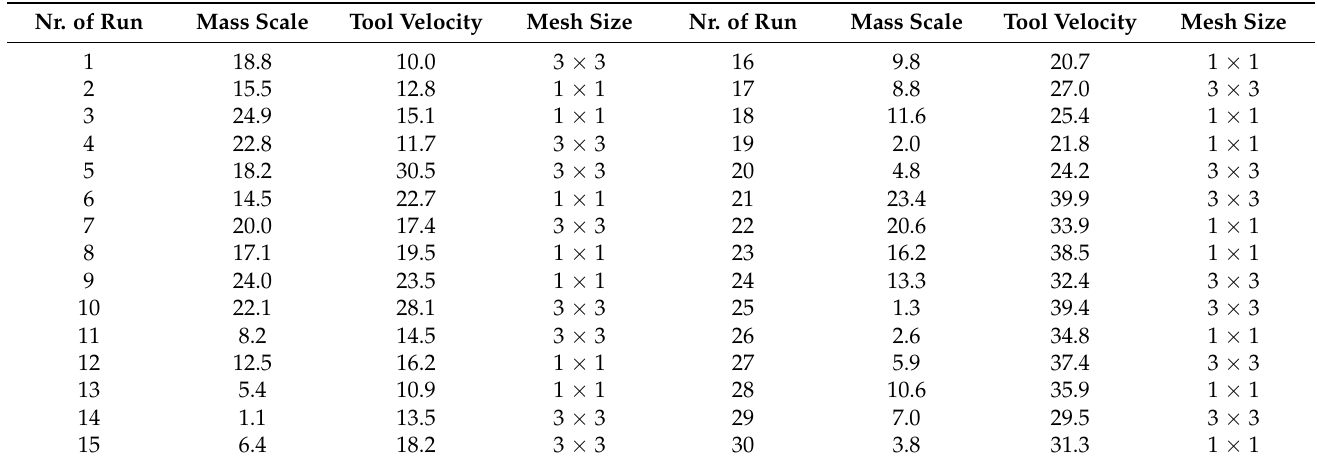
Figure 6. Measured part profile with pillowing detail (one half of the piece only). Table 1. Selected design points for ANN training purposes.